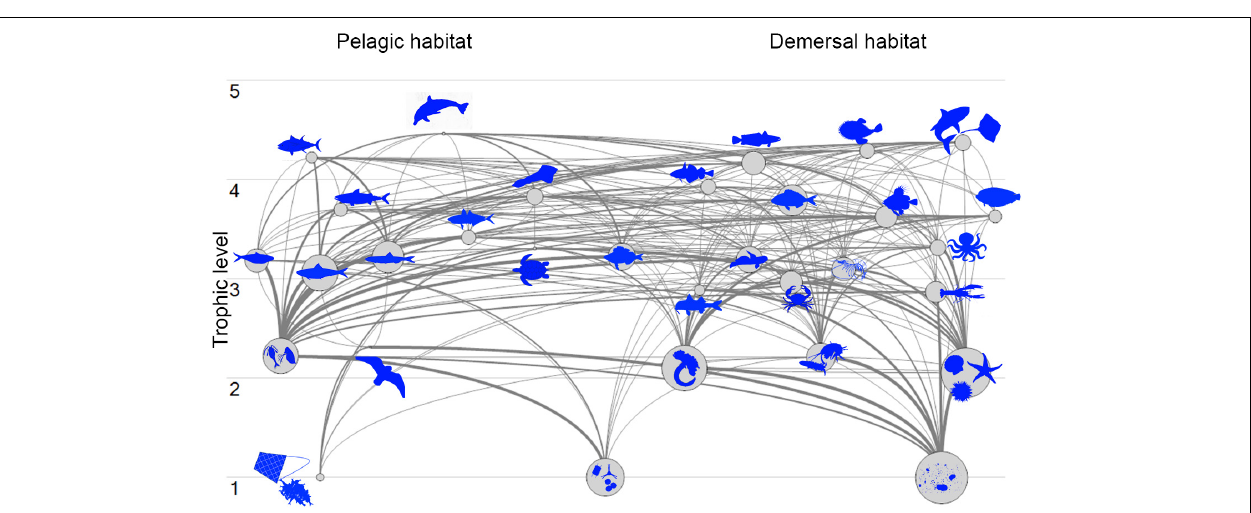
predator specifications, lack of microbial loop) and